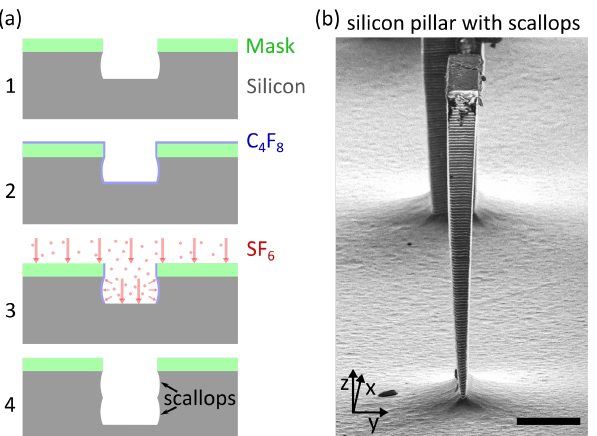
Figure 1. Bosch process. ( a ) Sketch of the Bosch process. (1) Silicon wafer with mask after one process cycle. (2) Deposition of a polymer layer during passivation. (3) Physical and chemical etching. (4) Silicon wafer with mask after two process cycles. ( b ) Scanning electron microscopy image of a 40 × 10 × 100µm (x,y,z) silicon pillar. The scallops that result from the sidewall etching are clearly visible. Scale bar corresponding to